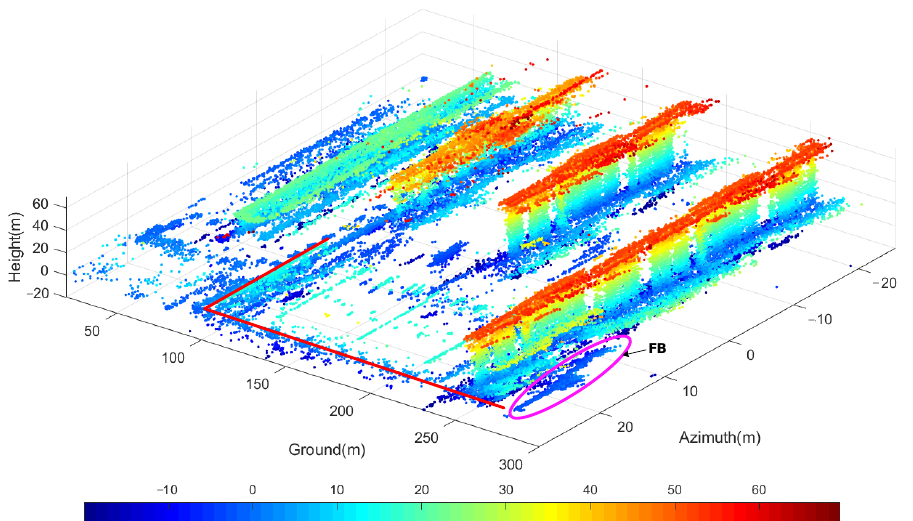
Figure 13. The original TomoSAR point cloud of the area marked by the yellow rectangular box in SAR image